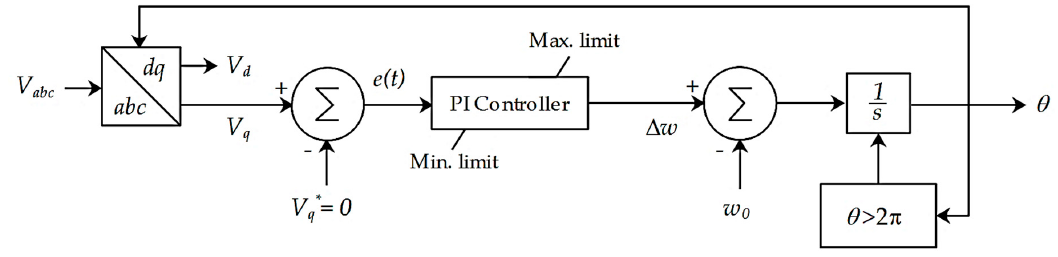
Figure 5. The PLL control diagram.